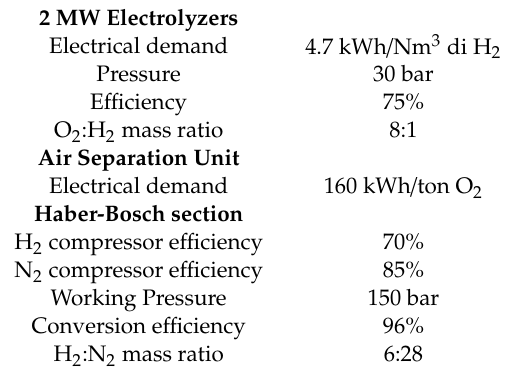
Table 2. Main technical assumptions for energy analysis